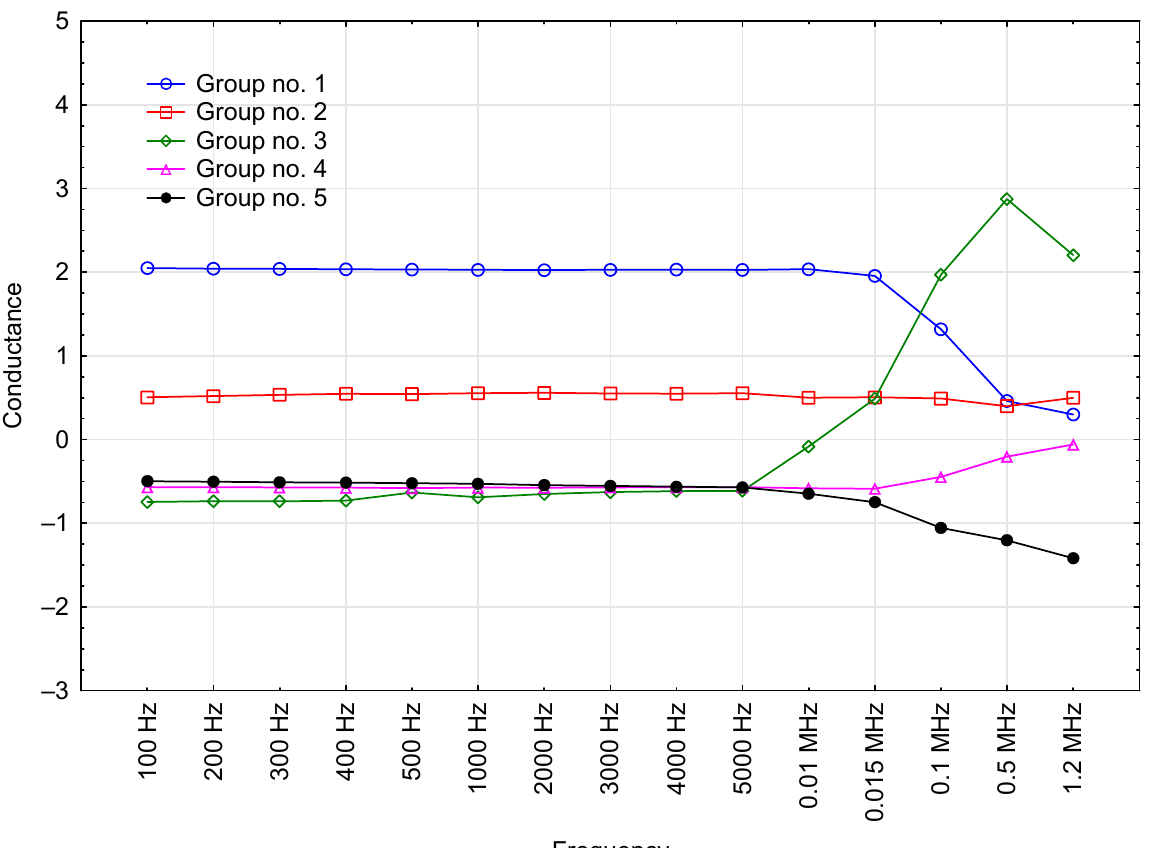
Figure 11. Effect of test voltage frequency on the average conductance value for engine oils in each cluster (grouped by k-means).